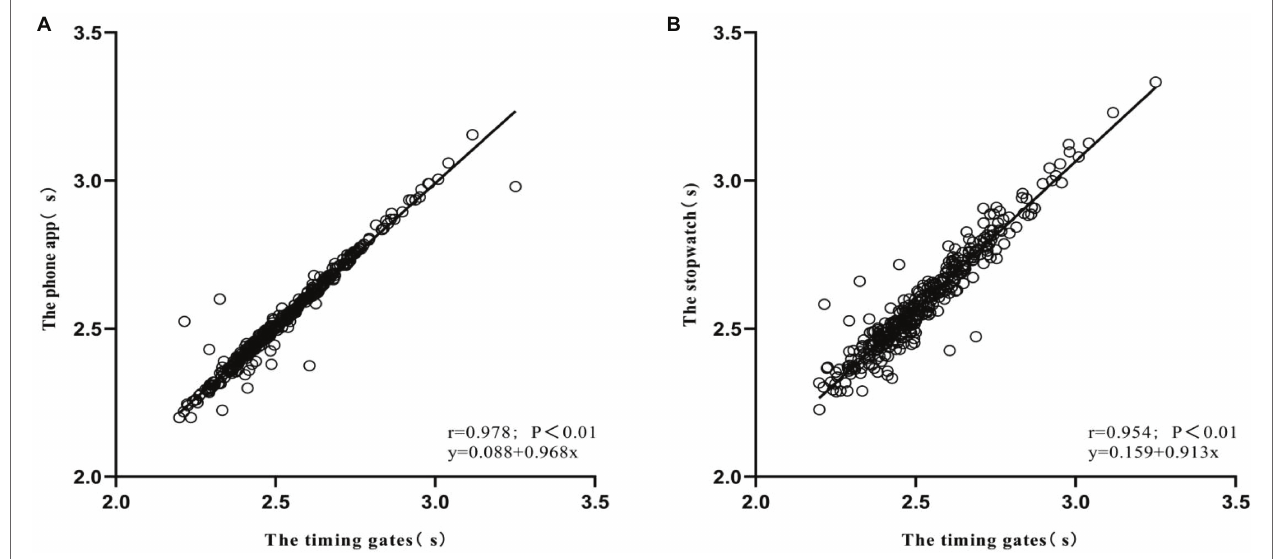
FIGURE 2 | Linear relationship between devices for the completion time: (A) phone app and timing gates; (B) stopwatch and timing gates.